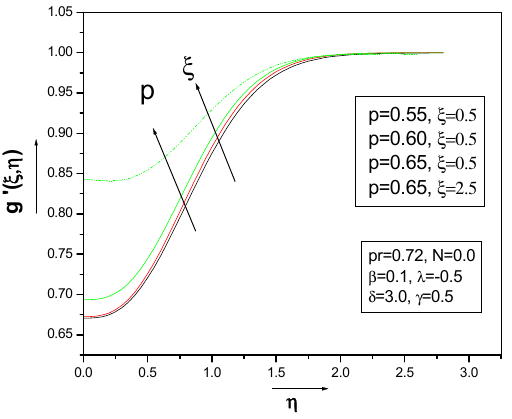
Figure 11. Effect of the velocity exponent parameter on magnetic field profile.